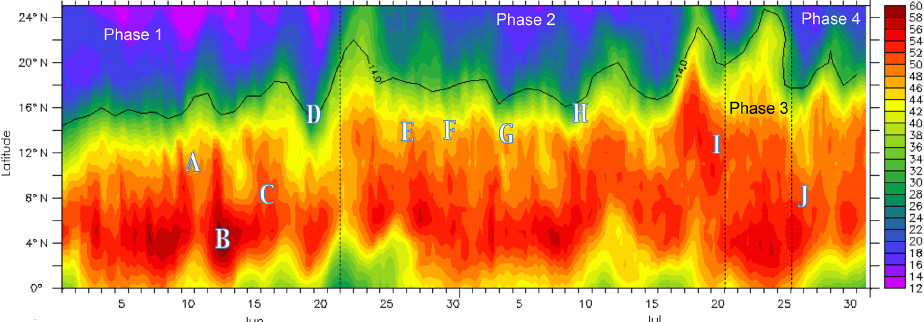
Figure 7. Evolution of TCWV (shading in millimetres) and the ITD (black line, identified from the 14 ◦ C isoline of 2m dew point) during June–July 2016 based on ECMWF operational analysis. The four phases of the DACCIWA campaign and significant synoptic-scale features A–J are marked at the approximate time and latitude of crossing the DACCIWA focus region as in Fig. 5b.